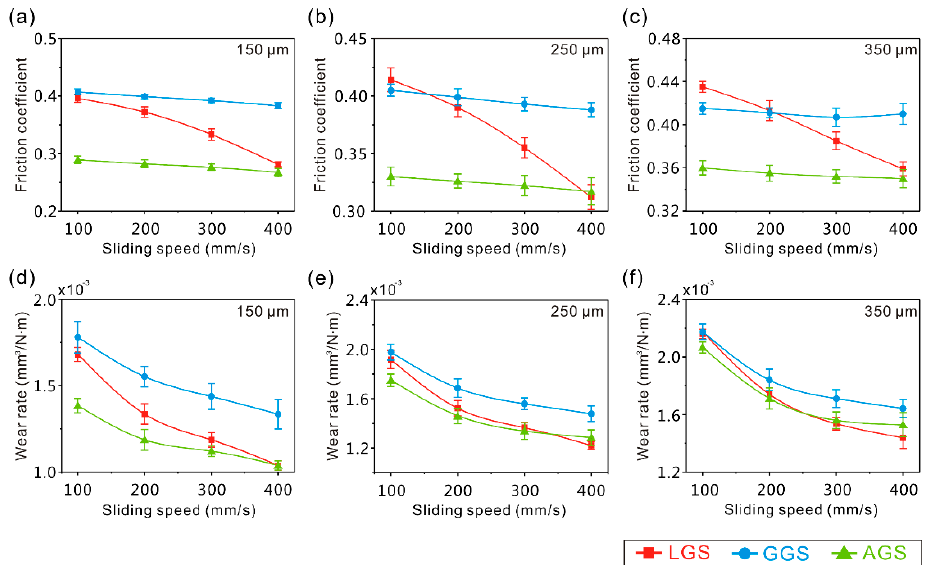
Figure 18. ( a – c ) Variations of the friction coefficient of the micro-scale structure surface samples with sliding speed; ( d – f ) variations of the wear rate of the micro-scale structure surface samples with sliding speed (load of 0.3 N, frictional pair of GCr15 bearing steel, friction time of 10 min).